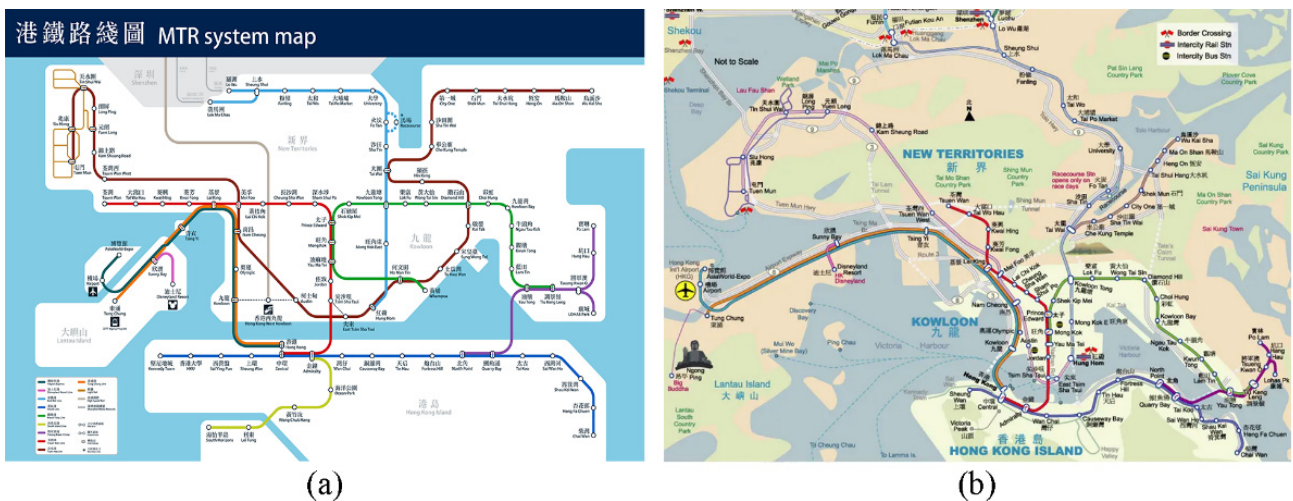
Figure 1. Comparison of name labels on: ( a ) schematic metro map with distorted lines and ( b ) navigation map with undistorted lines.